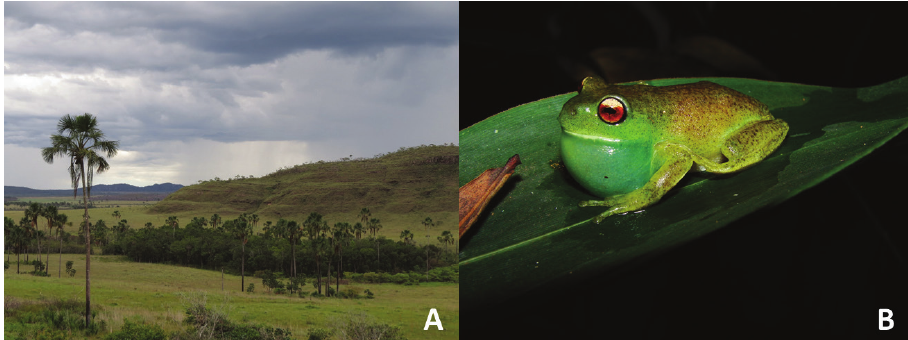
Figure 6. A The habitat of A. lutzorum sp. n.: flooded gallery forests B A male in calling activity at Fazenda Água Limpa, Brasília, Distrito Federal, Brazil.